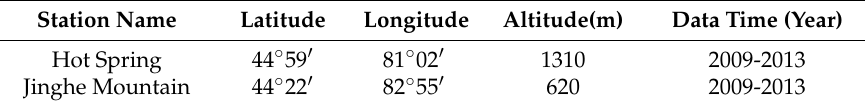
Table 2. Information relating to the hydrological stations in the